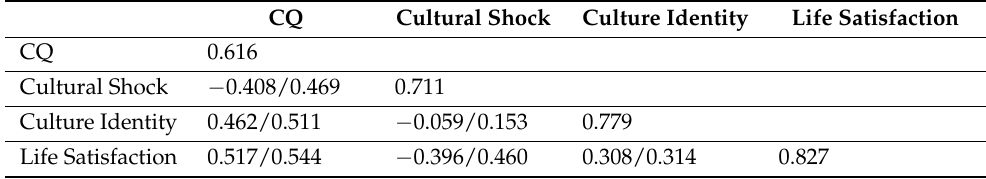
Table 1. Fornell–Larcker criterion/HTMT.